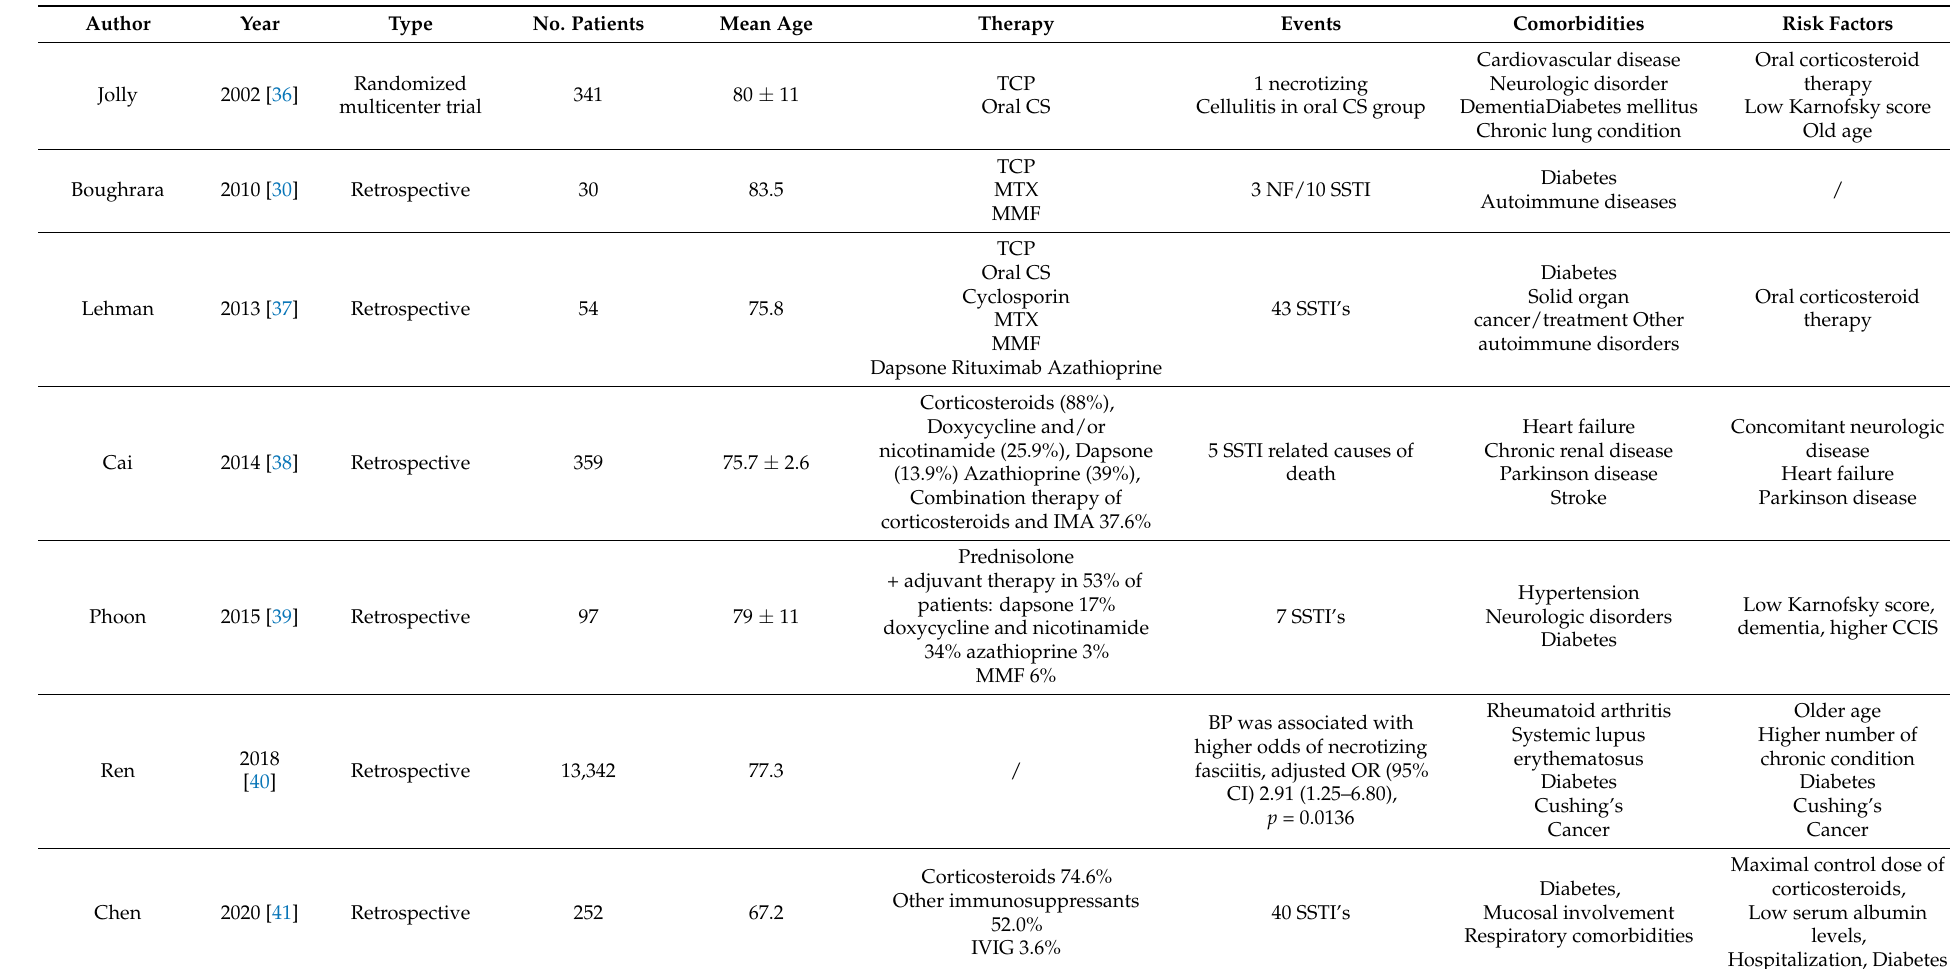
Table 2. A systematic review of all original articles